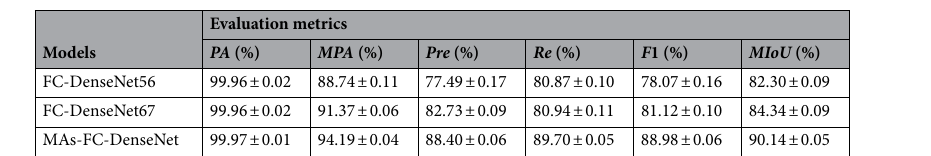
Table 2. Comparison of MA detection performance by FC-DenseNet56, FC-DenseNet67, and MAs-FC- DenseNet.